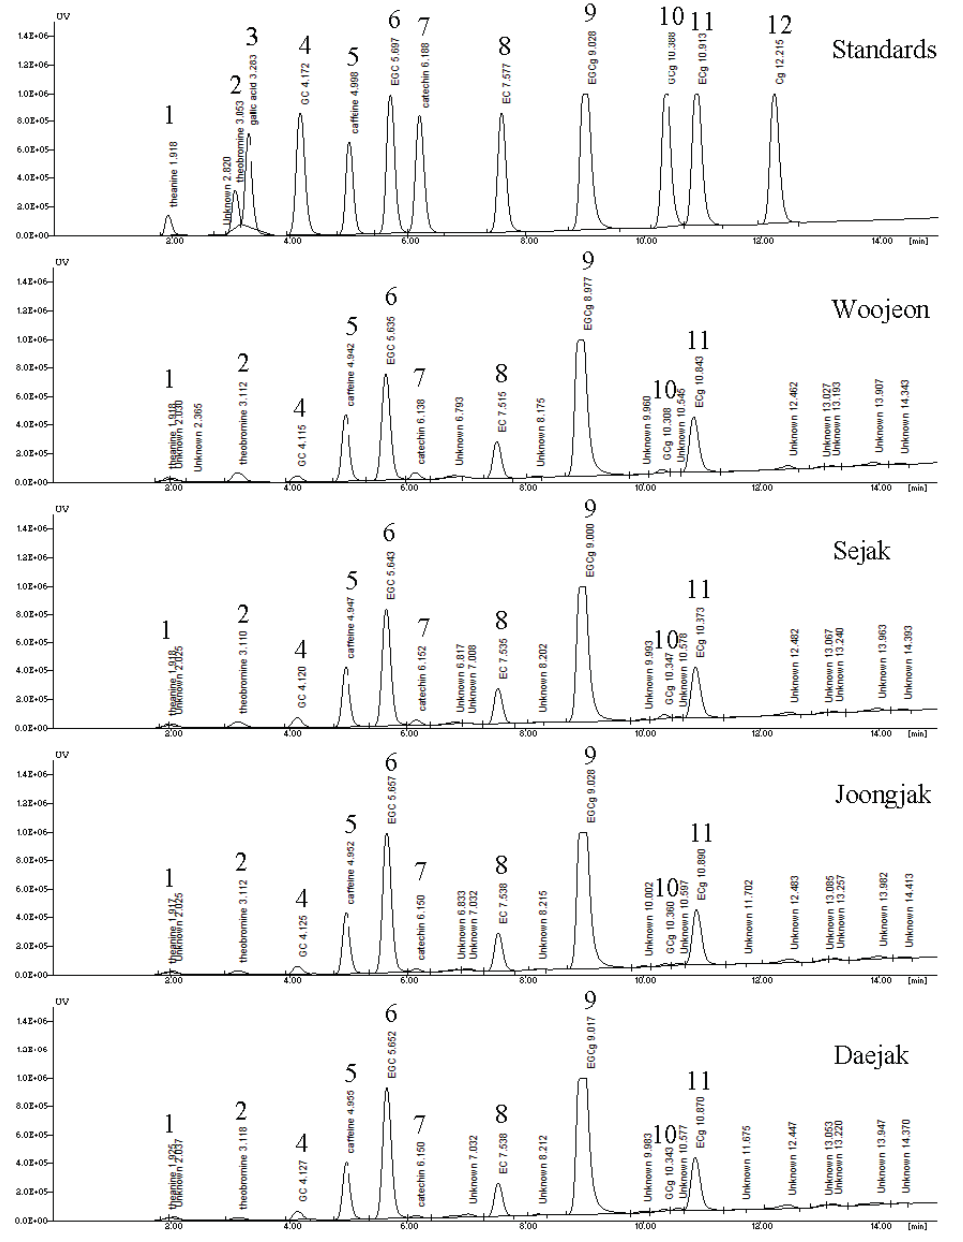
Figure 1. HPLC chromatograms of standard solution and green tea extracts with different plucking periods. Peaks correspond to ( 1 ) theanine, ( 2 ) theobromine, ( 3 ) gallic acid, ( 4 ) (+)-gallocatechin, ( 5 ) caffeine, ( 6 ) ( − )-epigallocatechin, ( 7 ) (+)-catechin, ( 8 ) ( − )-epicatechin, ( 9 ) ( − )-epigallocatechin gallate, ( 10 ) (+)-gallocatechin gallate, ( 11 ), ( − )-epicatechin gallate and ( 12 ) (+)-catechin gallate. Woojeon, first flush leaf of late April; Sejak, second flush leaf of early May; Joongjak, third flush leaf of mid-May; Daejak, fourth flush leaf of late